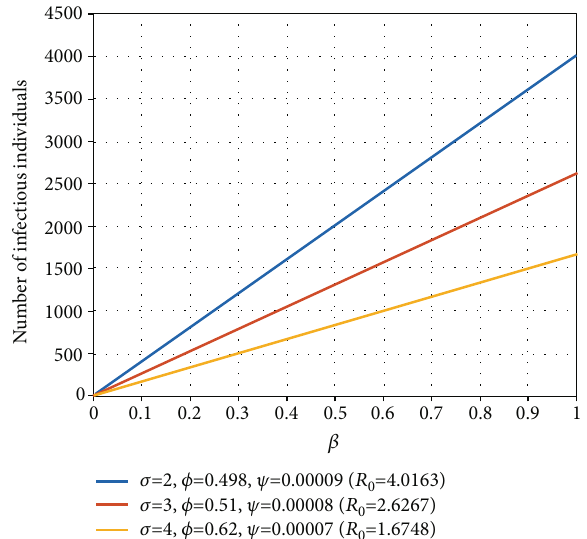
8: The e ff ect of σ , ϕ , and ψ on R 0 in the presence of β